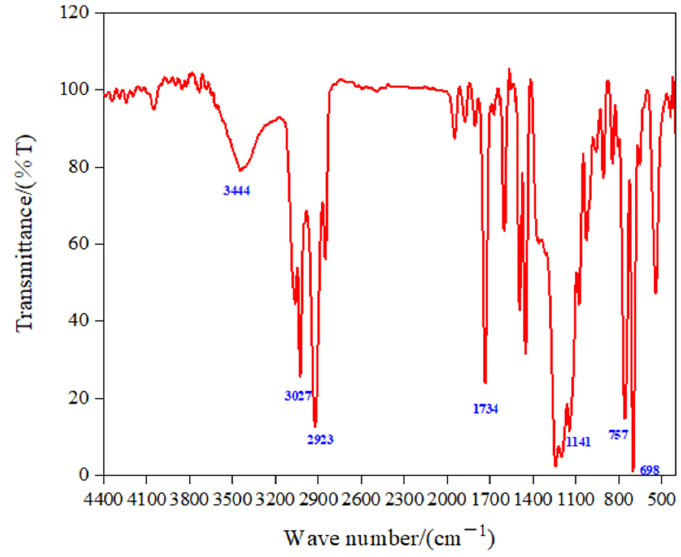
Figure 4. The infrared spectrum of the fluorinated nanoparticles.